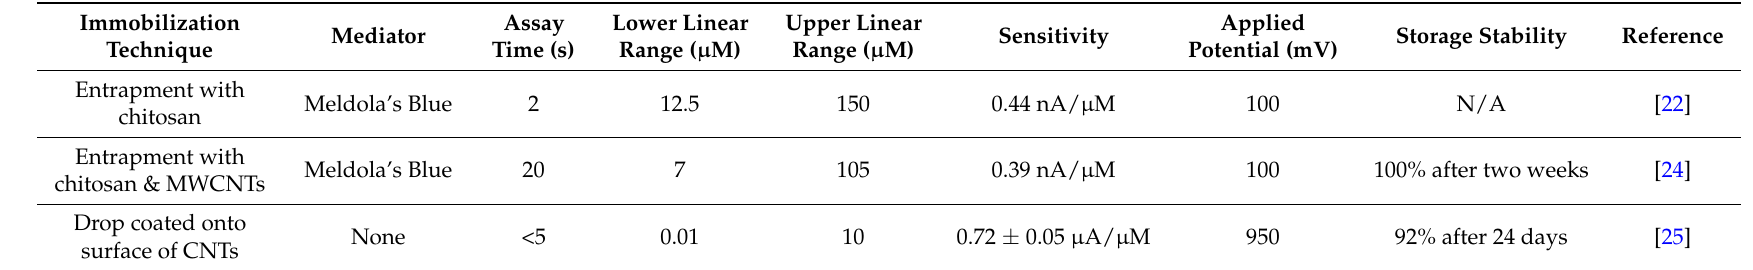
Table 3. Reports of screen-printed carbon electrodes for glutamate